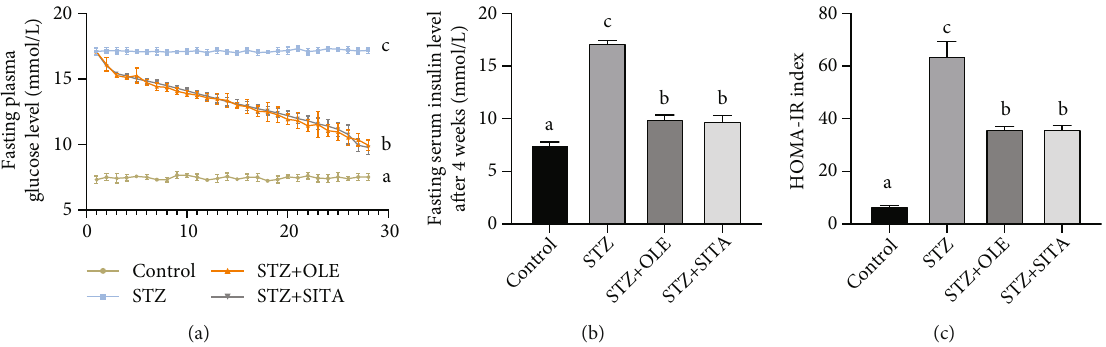
Figure 1: The e ff ect of oleuropein on insulin resistance in diabetic rats. (a) Fasting blood glucose levels during the test period (0-28 days). (b and c) At the end of the experiment (the 28th day), the fasting insulin levels (b) and HOMA-IR index (c). Each set contains data from 3 samples tested independently; LSD test was used for multiple comparisons. ∗∗ p < 0 : 05 vs. control group and ## p < 0 : 05 vs. STZ